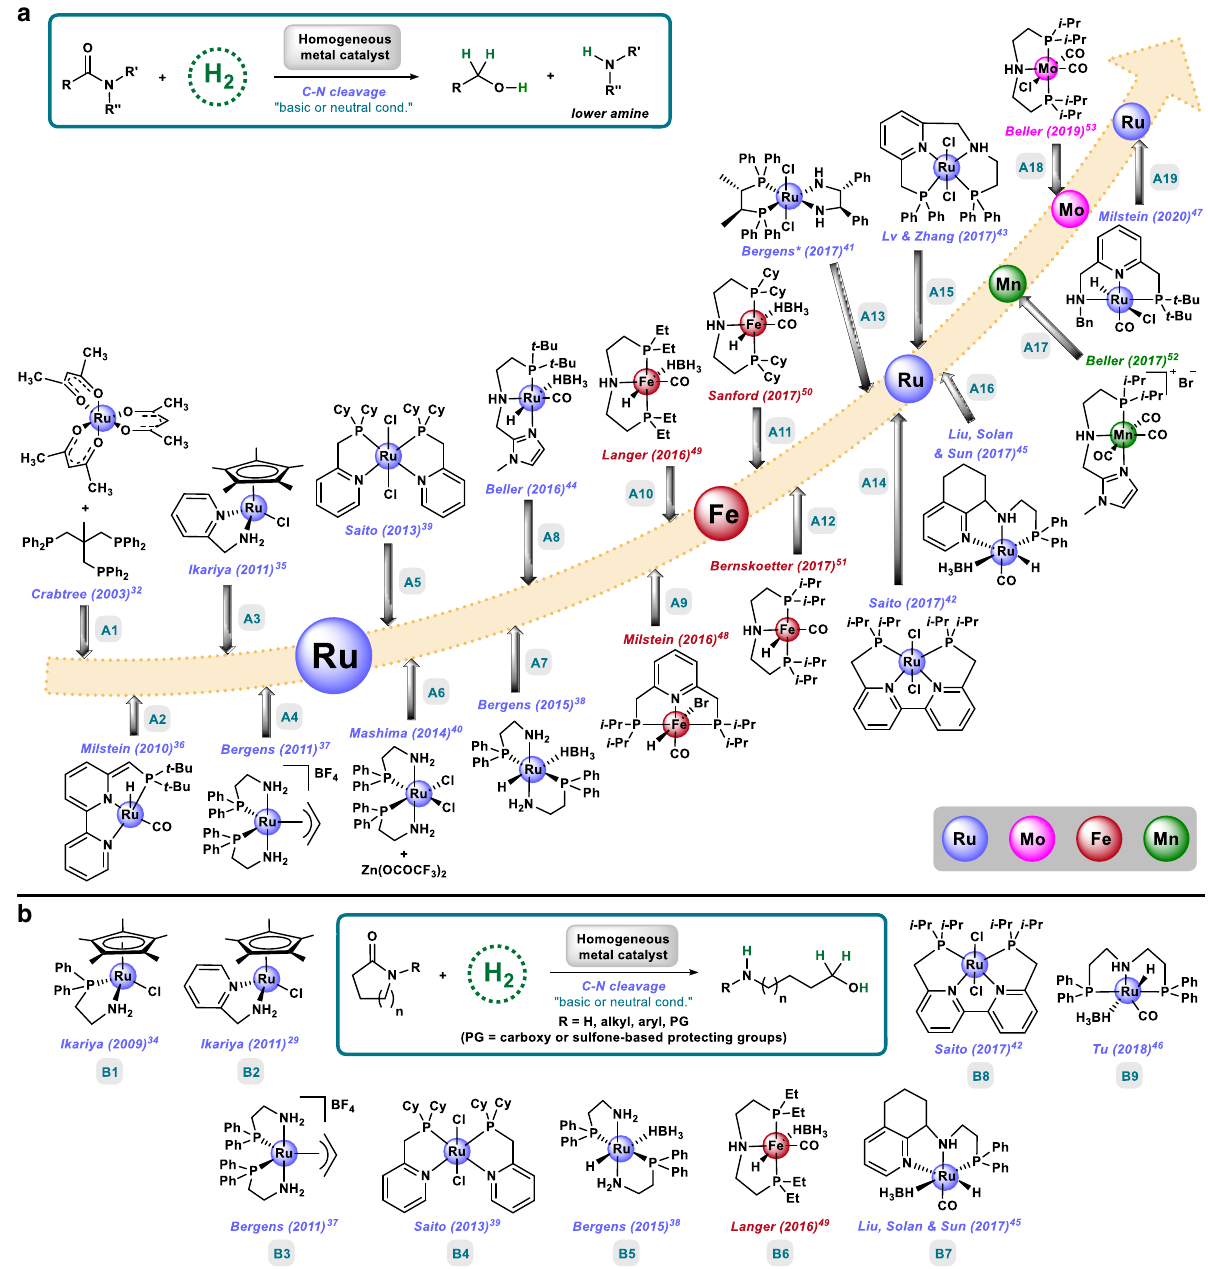
Fig. 2 Evolution of amide hydrogenation catalysts. a Homogeneous catalytic systems for hydrogenation of amides to alcohols and amines by selective C – N hydrogenolysis, from ruthenium to iron, manganese, and molybdenum. (* = enantioselective protocol). b Molecularly de fi ned complexes performing lactams hydrogenation to amino alcohols by C – N